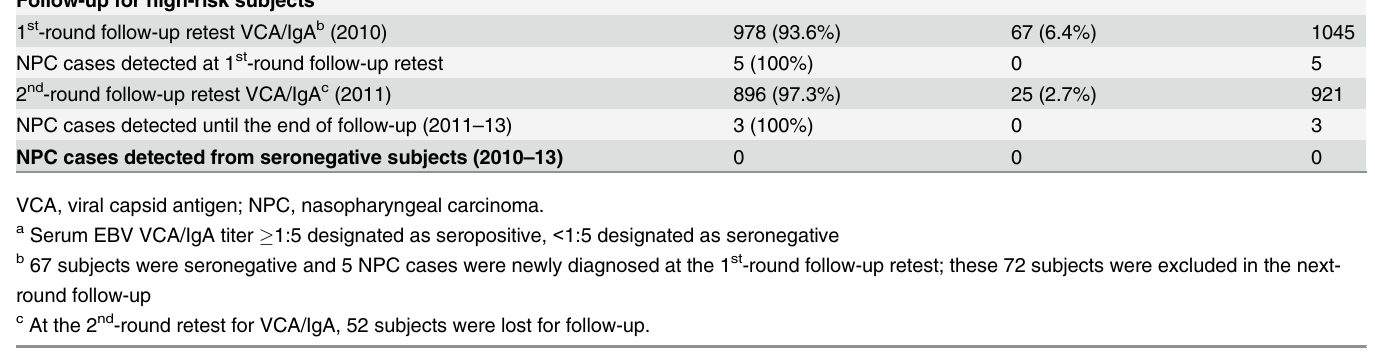
pathological biopsy were performed by otorhinolaryngologists to diagnose NPC. Of them 25 NPC cases were newly found, and the remaining 1045 subjects constituted our study cohort. In 2010, a follow-up serological and endoscopy examination were performed among the 1045 high-risk subjects. Besides serological test, otorhinolaryngologic and neck lymphatic examina- tion, these subjects were asked for donating a nasopharyngeal swab and undergoing a face-to- face interview using a questionnaire. In total, 917 subjects agreed to provide a nasopharyngeal swab. In 2011, these subjects were actively followed up by a repeated examination, and in 2012 – 2013, were followed up for NPC occurrence by linkage to Cangwu Cancer Registry. Five NPCs were newly diagnosed in year 2010, and 3 in year 2011 (Table 1). No new NPC cases were diagnosed in 2012 and 2013. According to the American Joint Committee on Cancer (AJCC) TNM Staging System (7th ed., 2010), 7 of the 8 cases were early-stage NPCs (2 cases of stage Ⅰ , 5 cases of stage Ⅱ , and 1 case of stage Ⅲ ), and the early diagnosis rate was 87.5%. The results of serological test and EBV viral load from the nasopharyngeal swabs in 2010 were used for analysis in this study.